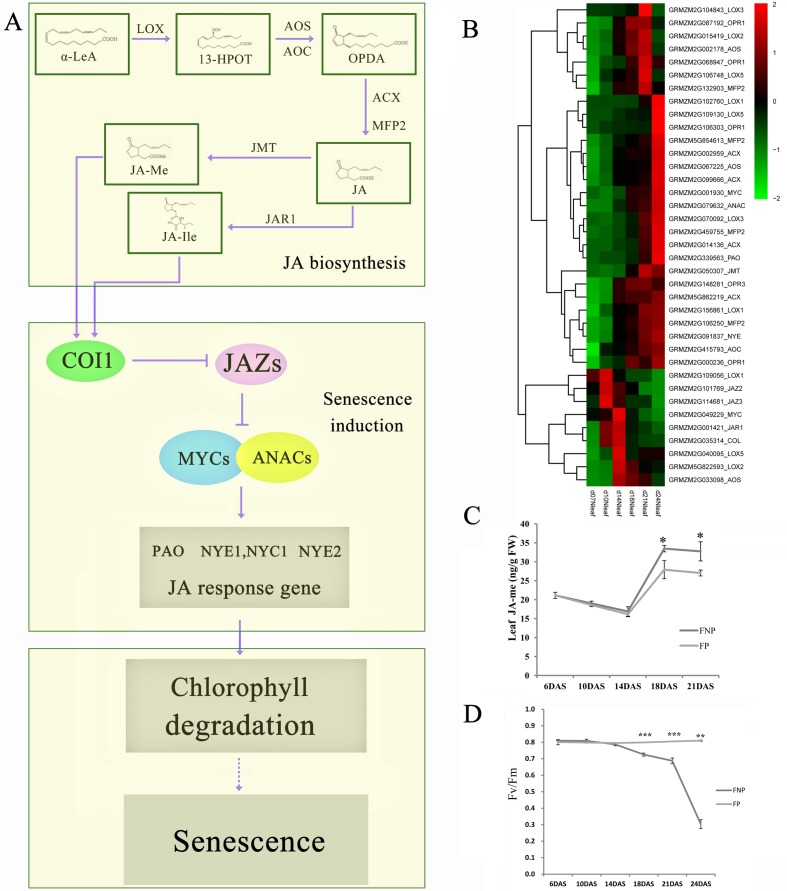
JA-related pathways may play key roles in senescence induction.(A) JA synthesis and signaling pathways with differential expression patterns in FNP plants. (B) Hierarchical clustering of JA-related genes. The color scale indicates the expression value. (C) Leaf JA contents of FNP and FP plants. (D) Changes in the photosynthetic maximum quantum yield (Fv/Fm) in the middle section of ear leaves. The data were derived from five experiments, and the standard deviation has been plotted. The bar represents the mean ± SE, n ≥ 8. *, p < 0.05; **, p < 0.01; ***, and p < 0.001.